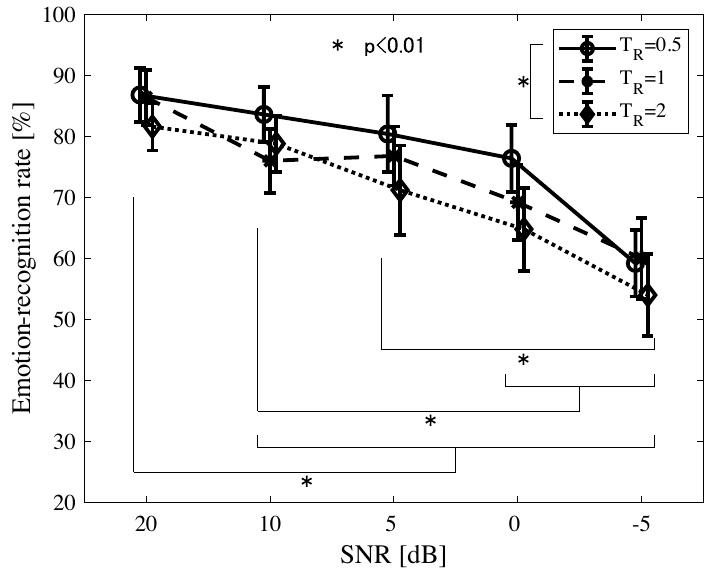
Figure 4. Vocal − emotion − recognition results in noisy reverberant environments